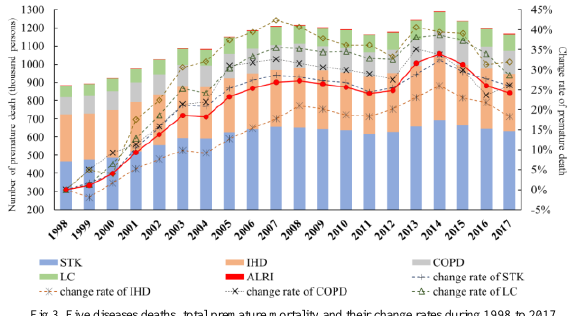
Fig.3. Five diseases deaths, total premature mortality and their change rates during 1998 to 2017 3.2.3 Spatial distribution of premature mortality: Figure 4